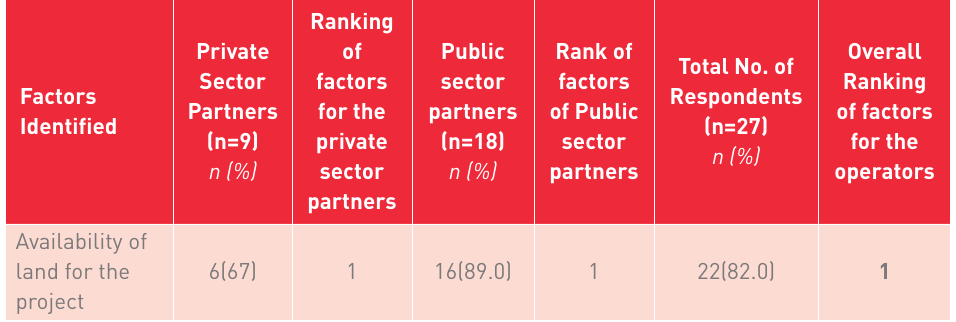
Summary of findings on Project Selection and Identification